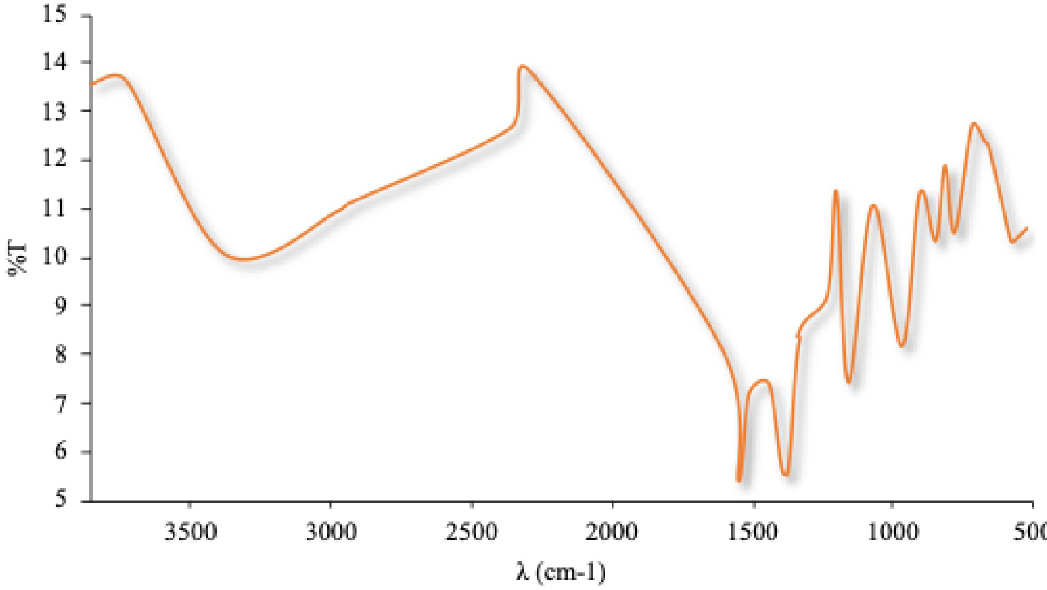
Fig 8. FT-IR rosuvastatin